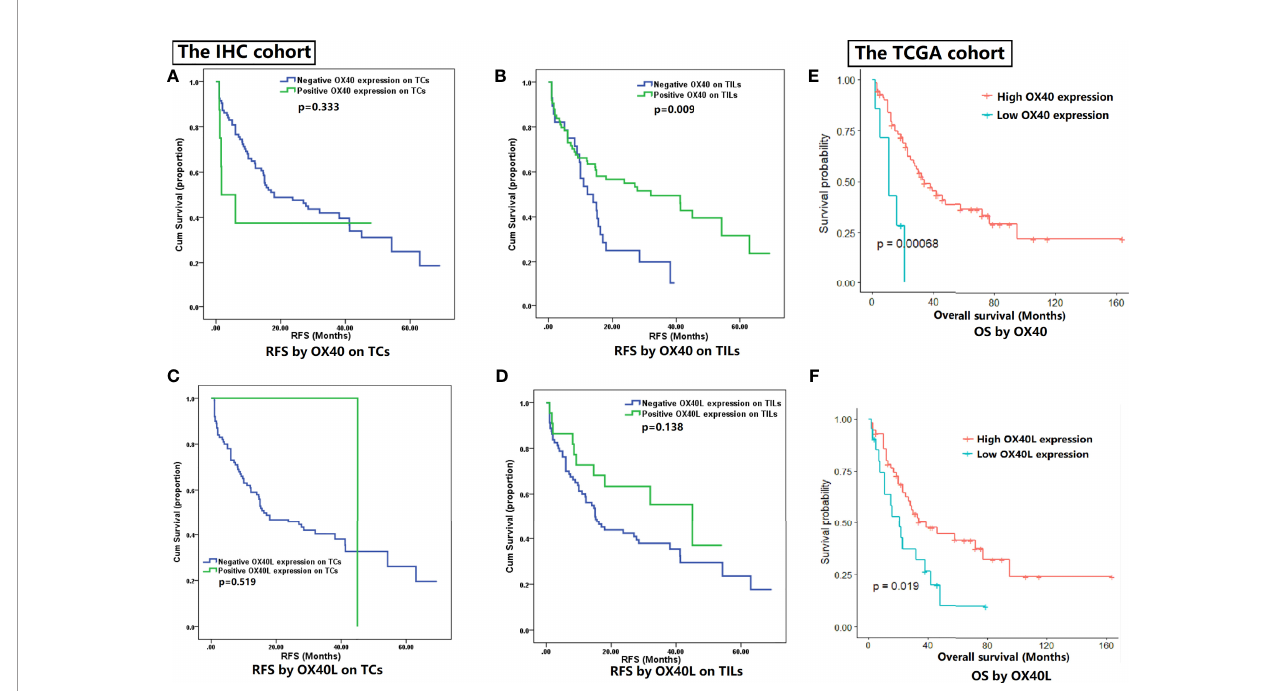
FIGURE 2 | Survival analysis for OX40 and OX40 ligand (OX40L) expression. (A) RFS by OX40 on TCs. (B) RFS by OX40 on TILs. (C) RFS by OX40L on TCs. (D) RFS by OX40L on TILs. (E) OS by OX40. (F) OS by